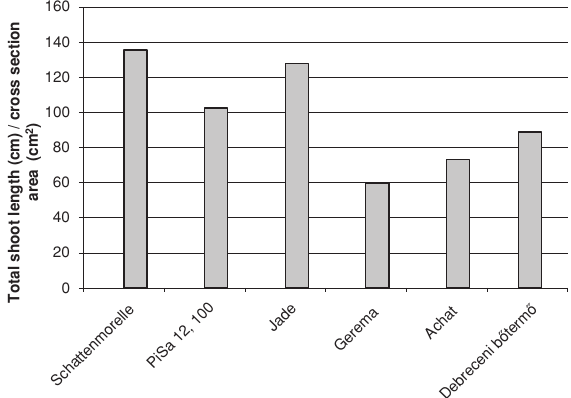
020406080100120140160